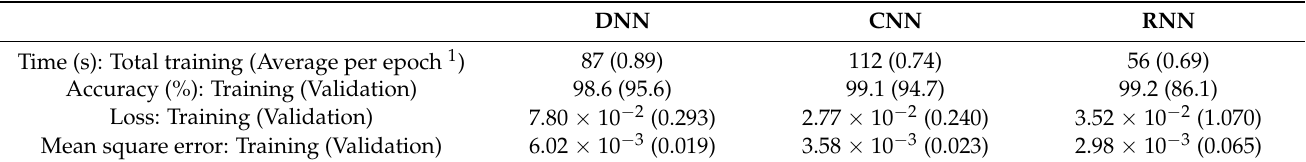
Table 2. Performances of networks for training (3420 waveforms) and validation (1140 waveforms).